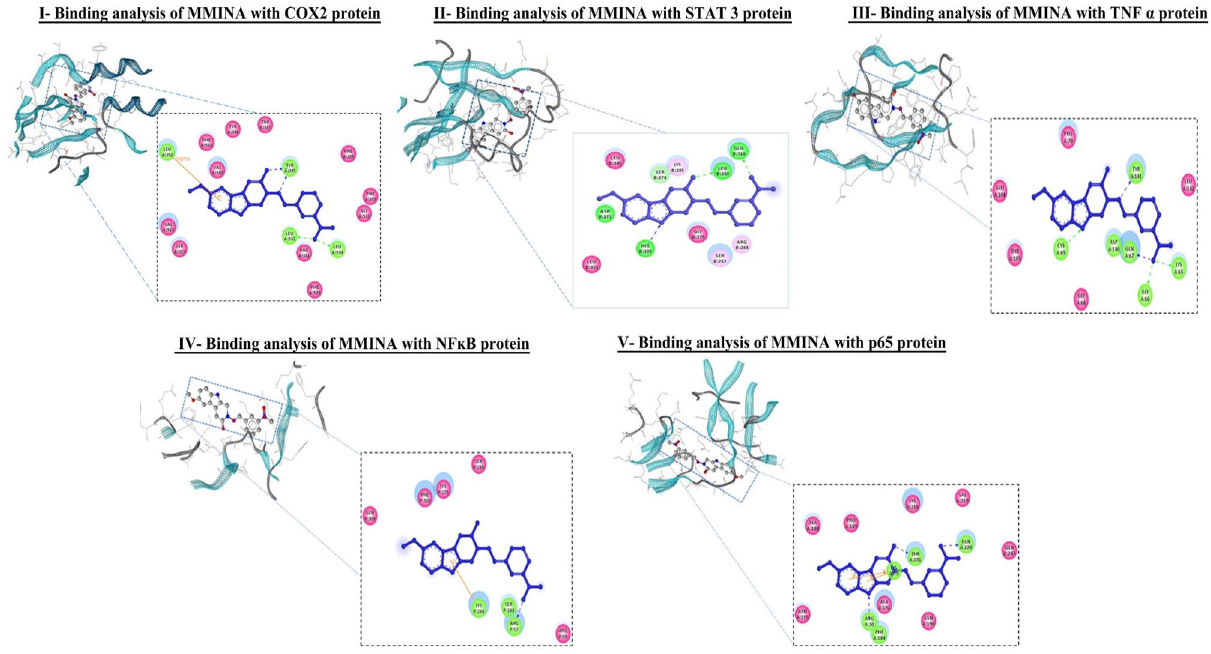
Figure 8. Binding analysis of MMINA with COX2, STAT3, TNF-α, NF-κB and p65protein. In the 3D confirmation, protein is shown in snake ribbon while the MMINA is shown in grey ball and stick model. In 2D representation blue ball and stick model represent the MMINA, residues involved in hydrophobic interactions are shown in pink disc while the residues involved in covalent and coordinate covalent interactions are shown in green discs. orange lines indicating pi-interactions in p65.